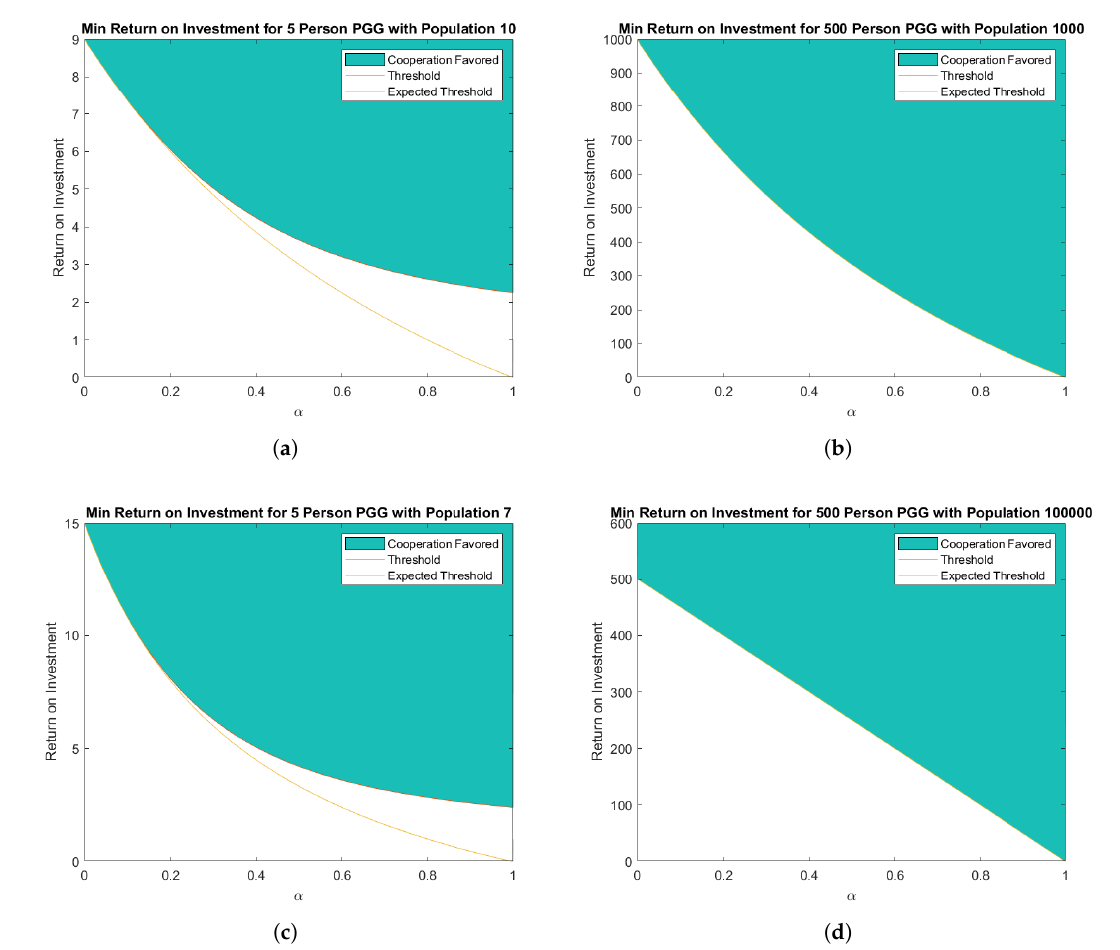
Figure 3. Critical threshold R ( α ) of the PGG investment return (i.e., enhancement factor) r required for cooperation to be favored. The shaded areas represent combinations of the PGG enhancement factor r and the probability of non-participation (i.e., opting-out) α which promote cooperation for game size N = 5 and n = 10 in ( a ), N = 500 and n = 1000 in ( b ), N = 5 and n = 7 in ( c ), and N = 500 and n = 1,000,000 in ( d ). The yellow line in each panel is the approximation R exp ( α ) as given in Equation